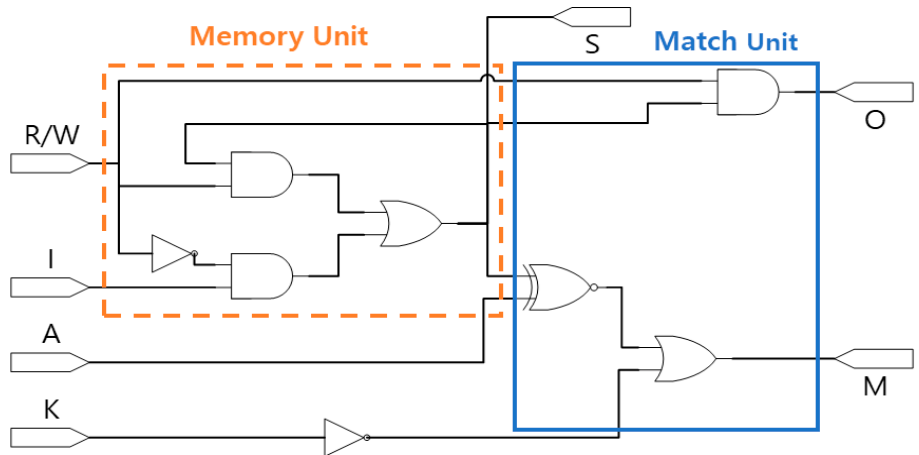
( d ) Figure 8. Conventional QCA CAM cells: ( a ) L. H. B. Sardinha et al.’s [44]; ( b ) S. R. Heikalabad et al.’s [45]; ( c ) M. B. Khosroshahy et al.’s [46]; ( d ) A. Sadoghifar et al.’s [47]. 3. Proposed CAM Cell Although the required area of the QCA XOR gate has been improved by designing it using electron interaction, it is designed as a single-layer structure, which results in a spa- tial limitation. Therefore, this paper proposes a QCA XOR gate with an improved space efficiency using a multi-layer structure and an electron interaction design technique. Fig- ure 9 shows the proposed XOR/XNOR circuit designed with a two-layer structure and based on the electronic interaction to increase the space efficiency compared to the exist- ing circuits. In addition, the proposed circuit can implement an XNOR gate without using an inverter by changing the polarization of the fixed cells in the second layer from − 1 to 1 as shown in Figure 9c. ( a ) ( c ) Figure 9. Proposed XOR/XNOR gates: ( a ) Layer 1-common structure; ( b ) Layer 2-XOR structure; ( c ) Layer 2-XNOR structure.